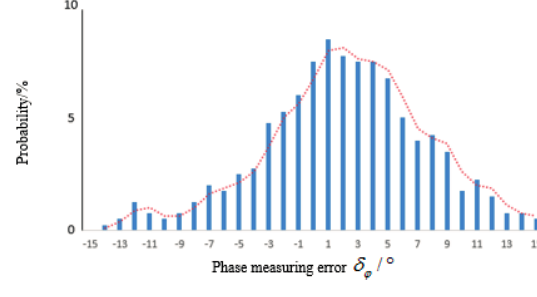
Figure 9. Distribution of phase measuring error.